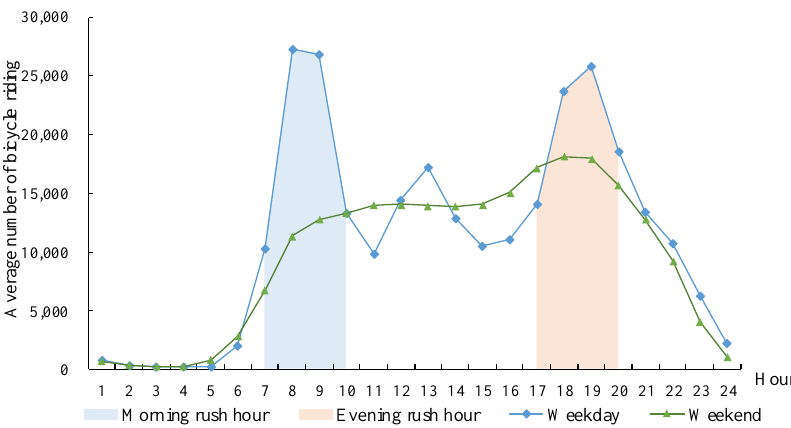
Figure 3. The number of bicycle trips per hour.